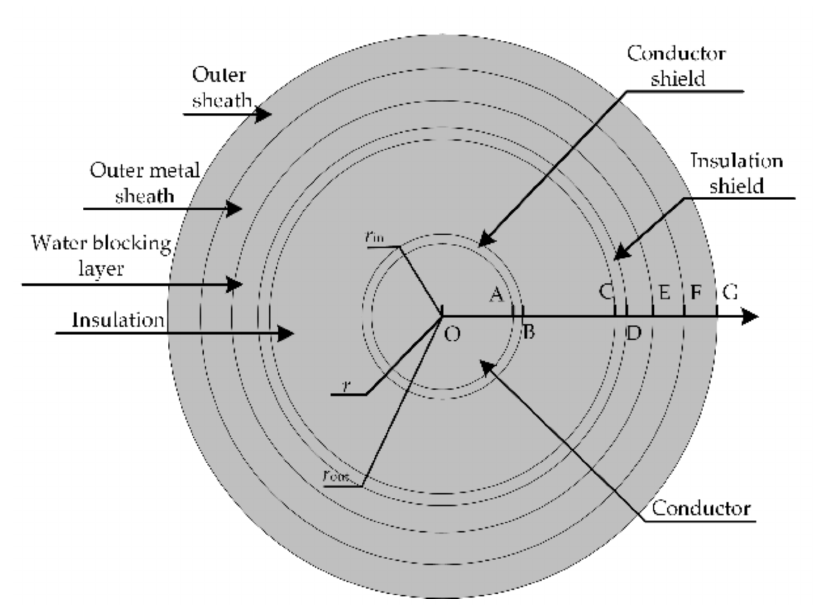
Figure 2. The simulated geometric